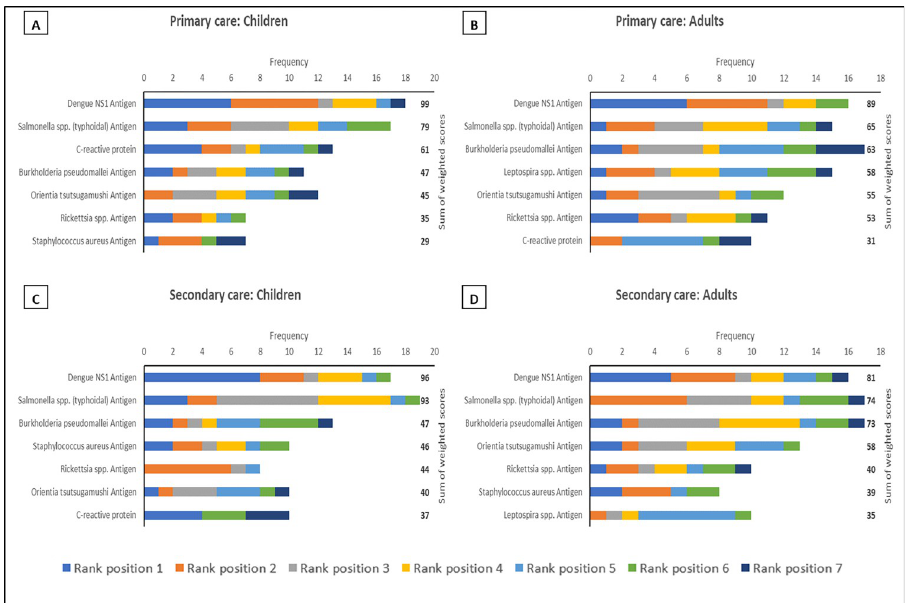
Fig 1. The top seven analytes, in descending order of priority based on sum of weighted scores, which should be considered for inclusion in multiplex lateral flow rapid diagnostic tests for acute non-malarial fever using fingerprick blood as the test substrate, in the following patient populations in Mainland Southeast Asia: (A) Children presenting to primary care settings (B) Adults presenting to primary care settings (C) Children being admitted to secondary care settings (D) Adults being admitted to secondary care settings. Children were defined as patients aged > 28 days and < 15 years. An analyte in rank position 1 was weighted seven times more than an analyte in rank position 7; the maximum sum of weighted scores per analyte was 161.